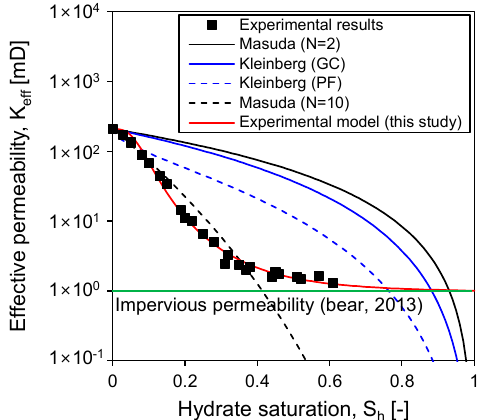
Figure 5. Comparison between proposed model and existing permeability models.